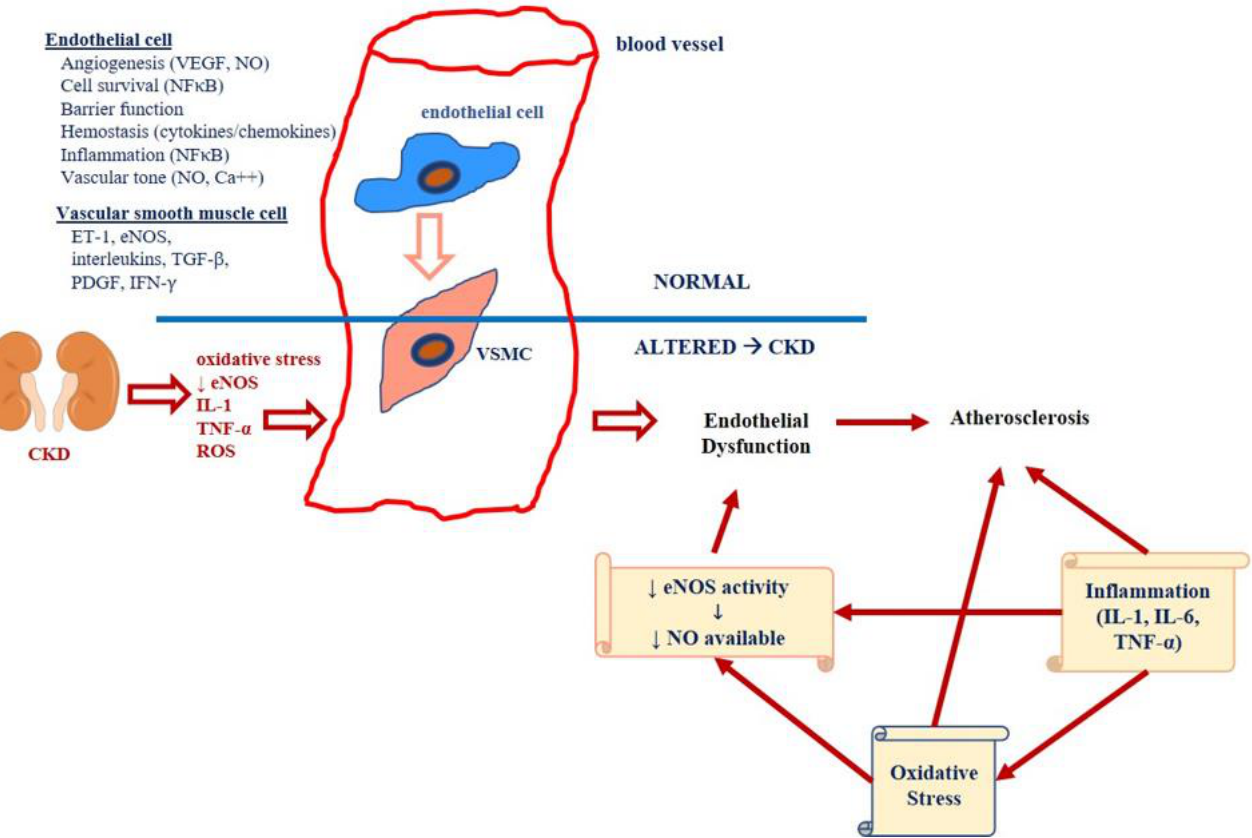
Figure 2. Effect of chronic kidney disease (CKD)-related factors on the vascular endothelium. Oxidative mediators involved in endothelial cell and vascular smooth muscle cell function and relationship with Chronic Kidney Disease (CKD). Abbreviations: eNOS, endothelial nitric oxide synthase; IL-, interleukin-; IL6, interleukin6; NF-κB, nuclear factor kappa-light-chain-enhancer of activated B cell; NO, nitric oxide; TNF, tumor necrosis factor-alpha; NO, nitric oxide; ET-1, endothelin 1; PDGF, platelet-derived growth factor; IFN-γ, interferon-gamma; TGF-β, tumor growth factor-beta; VEGF, vascular endothelial growth factor.